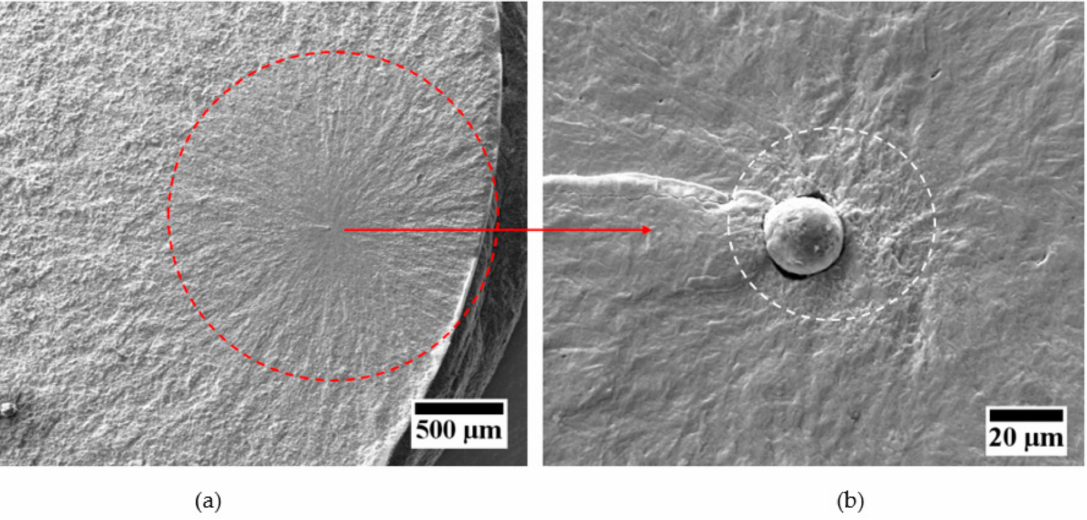
Figure 8. Fracture surface of the 50CrMo4—57HRC steel with a fisheye (( a ), red circle) and crack initiation at a non-metallic inclusion (type Al 2 O 3 -CaO) surrounded by FGA (( b ), white circle), tested at 95 Hz, σ a = 480 MPa.